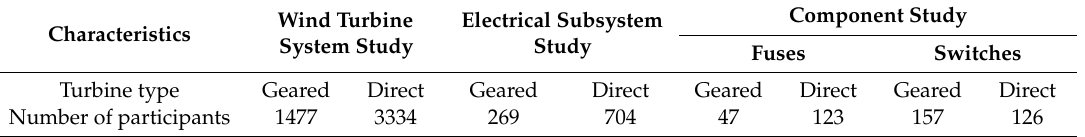
Table 4. Number of wind turbine participants considered in this